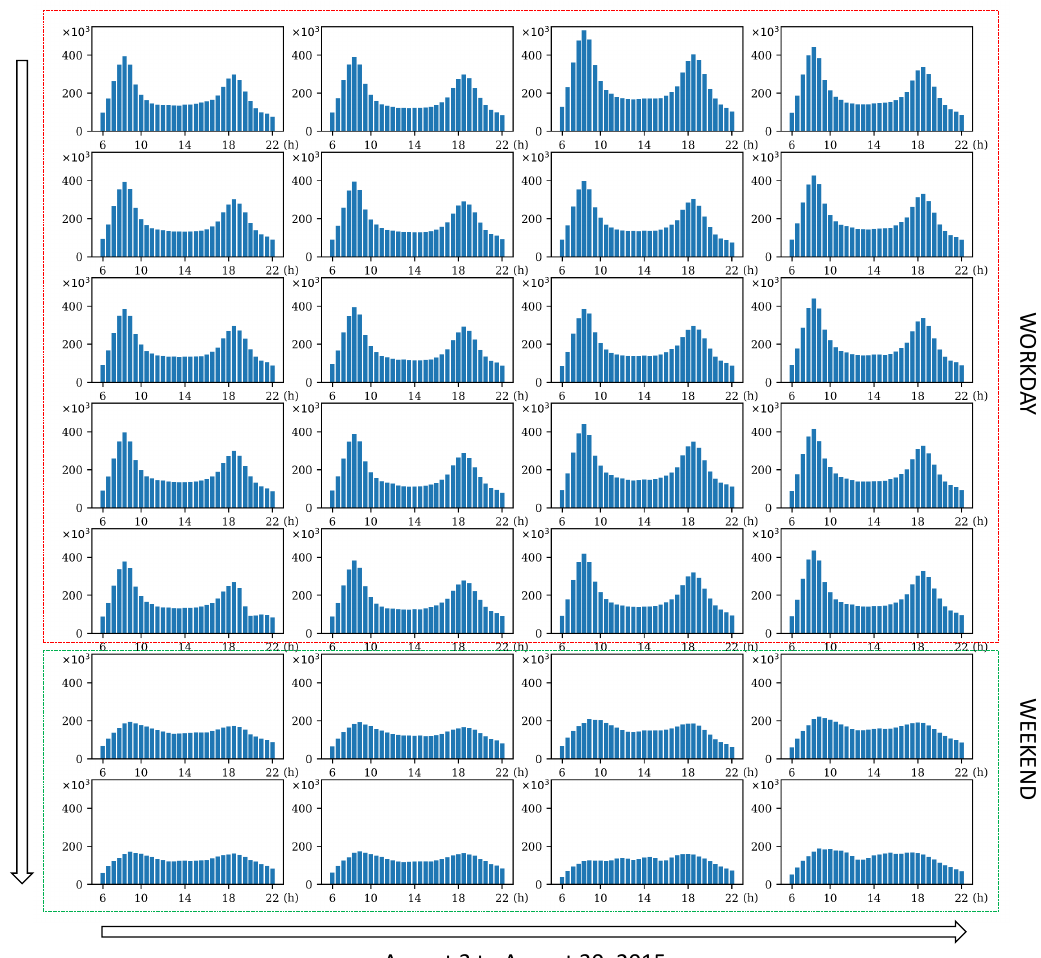
Figure 5. Bus total traffic flow. Each subgraph represents the total traffic flow of all regions at each time interval in one